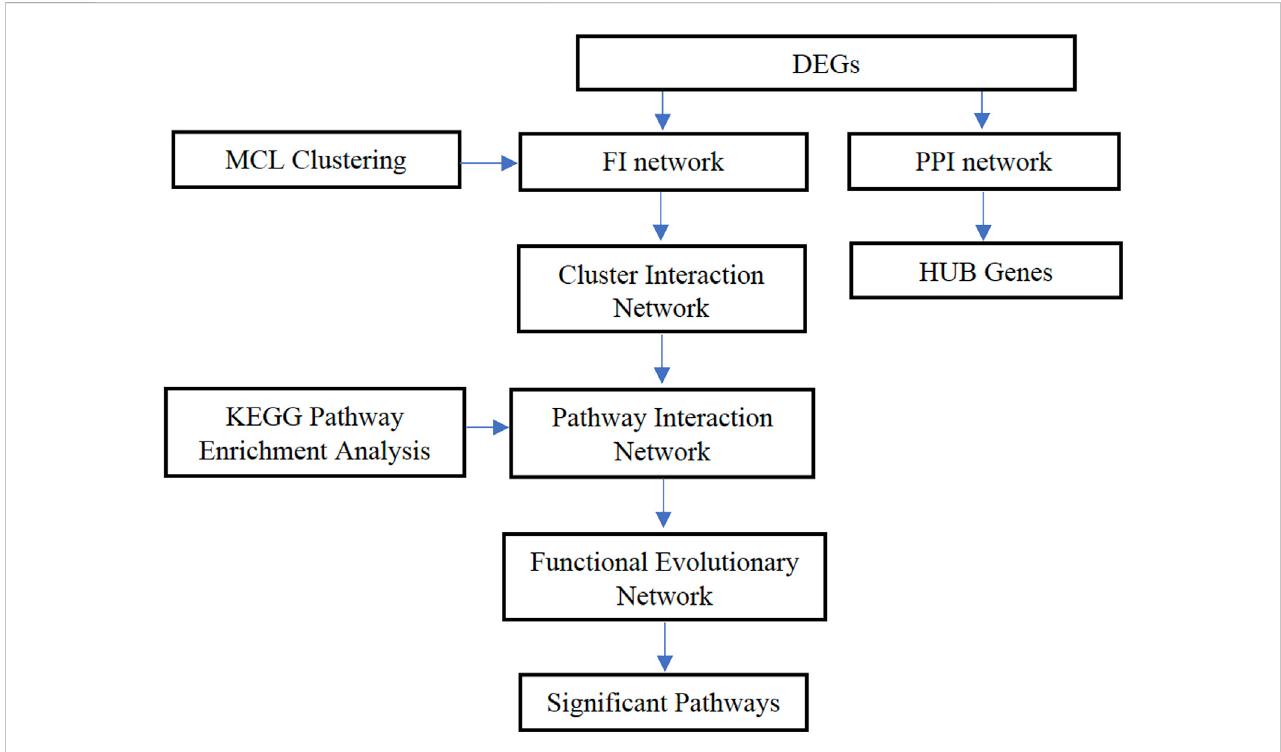
FIGURE 1 The overall framework of the proposed